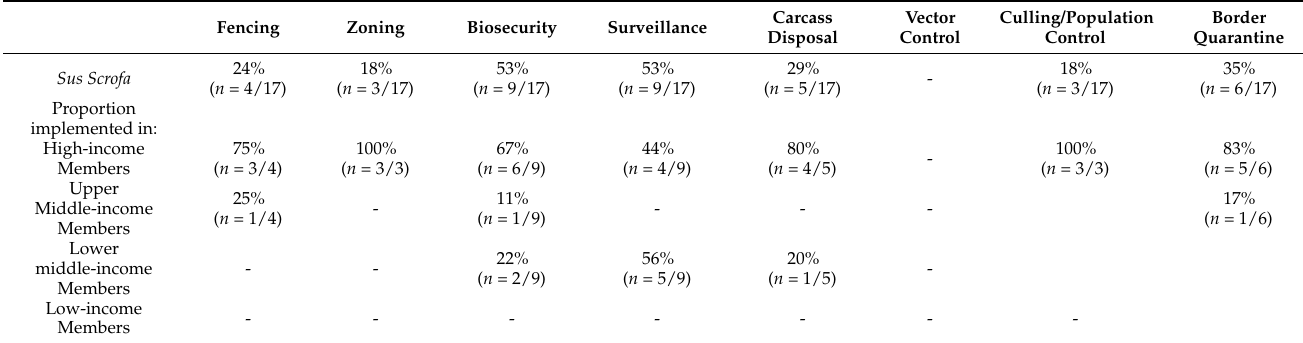
Table 7. Proportion of different control methods for Sus scrofa applied throughout Asia and the Pacific reported in the survey.